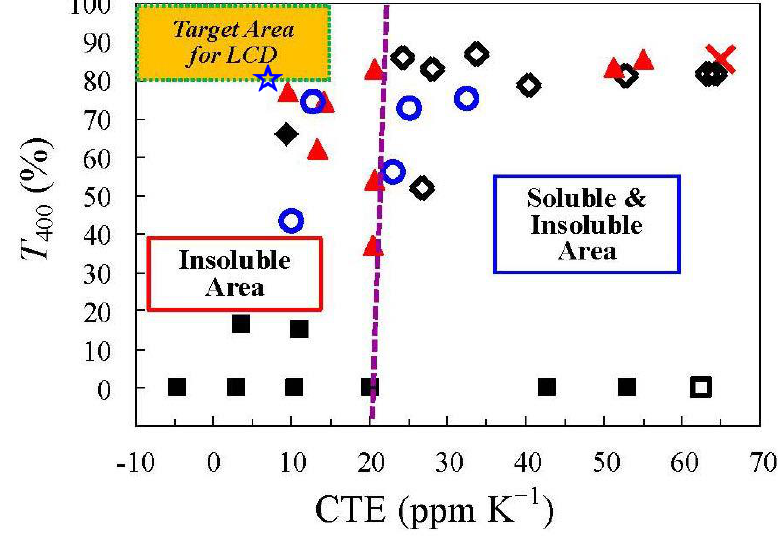
Figure 18. CTE–transparency ( T 400 )–solubility diagram for selected PI systems that we have investigated so far. Open and closed symbols denote soluble (compatible with the chemical imidization process) and insoluble systems, respectively. An open-star symbol denotes the CBDA (70); 6FDA(30)/AB-TFMB copolymer system, ( ■ ,□) conventional wholly aromatic PIs, ( ♦ ) CBDA/DABA, ( ▲ ) insoluble semi-cycloaliphatic PIs obtained using CBDA or cycloaliphatic diamines and TFMB-based PIs, ( ◊ ) soluble PIs obtained using H-PMDA, H″-PMDA, or HTA-HQ, ( ○ ) PIs obtained using TA-TFMB or TA-TFBP, ( ) PES. Reproduced with permission from Elsevier [21].